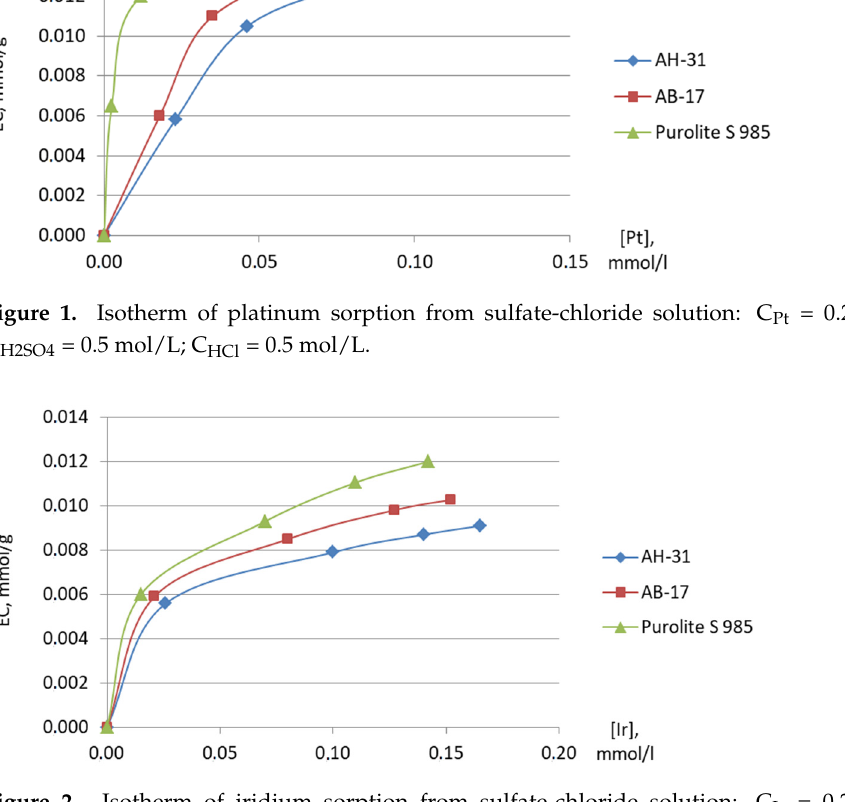
Figure 2. Isotherm of iridium sorption from sulfate-chloride solution: C Ir = 0.26 mmol/L; C H2SO4 = 0.5 mol/L; C HCl = 0.5 mol/L.